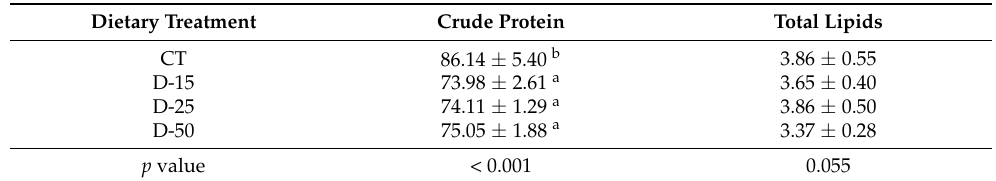
Table 5. Body chemical composition (g kg − 1 dry weight) of L. vannamei fed the experimental diets for 70 days. Dietary Treatment